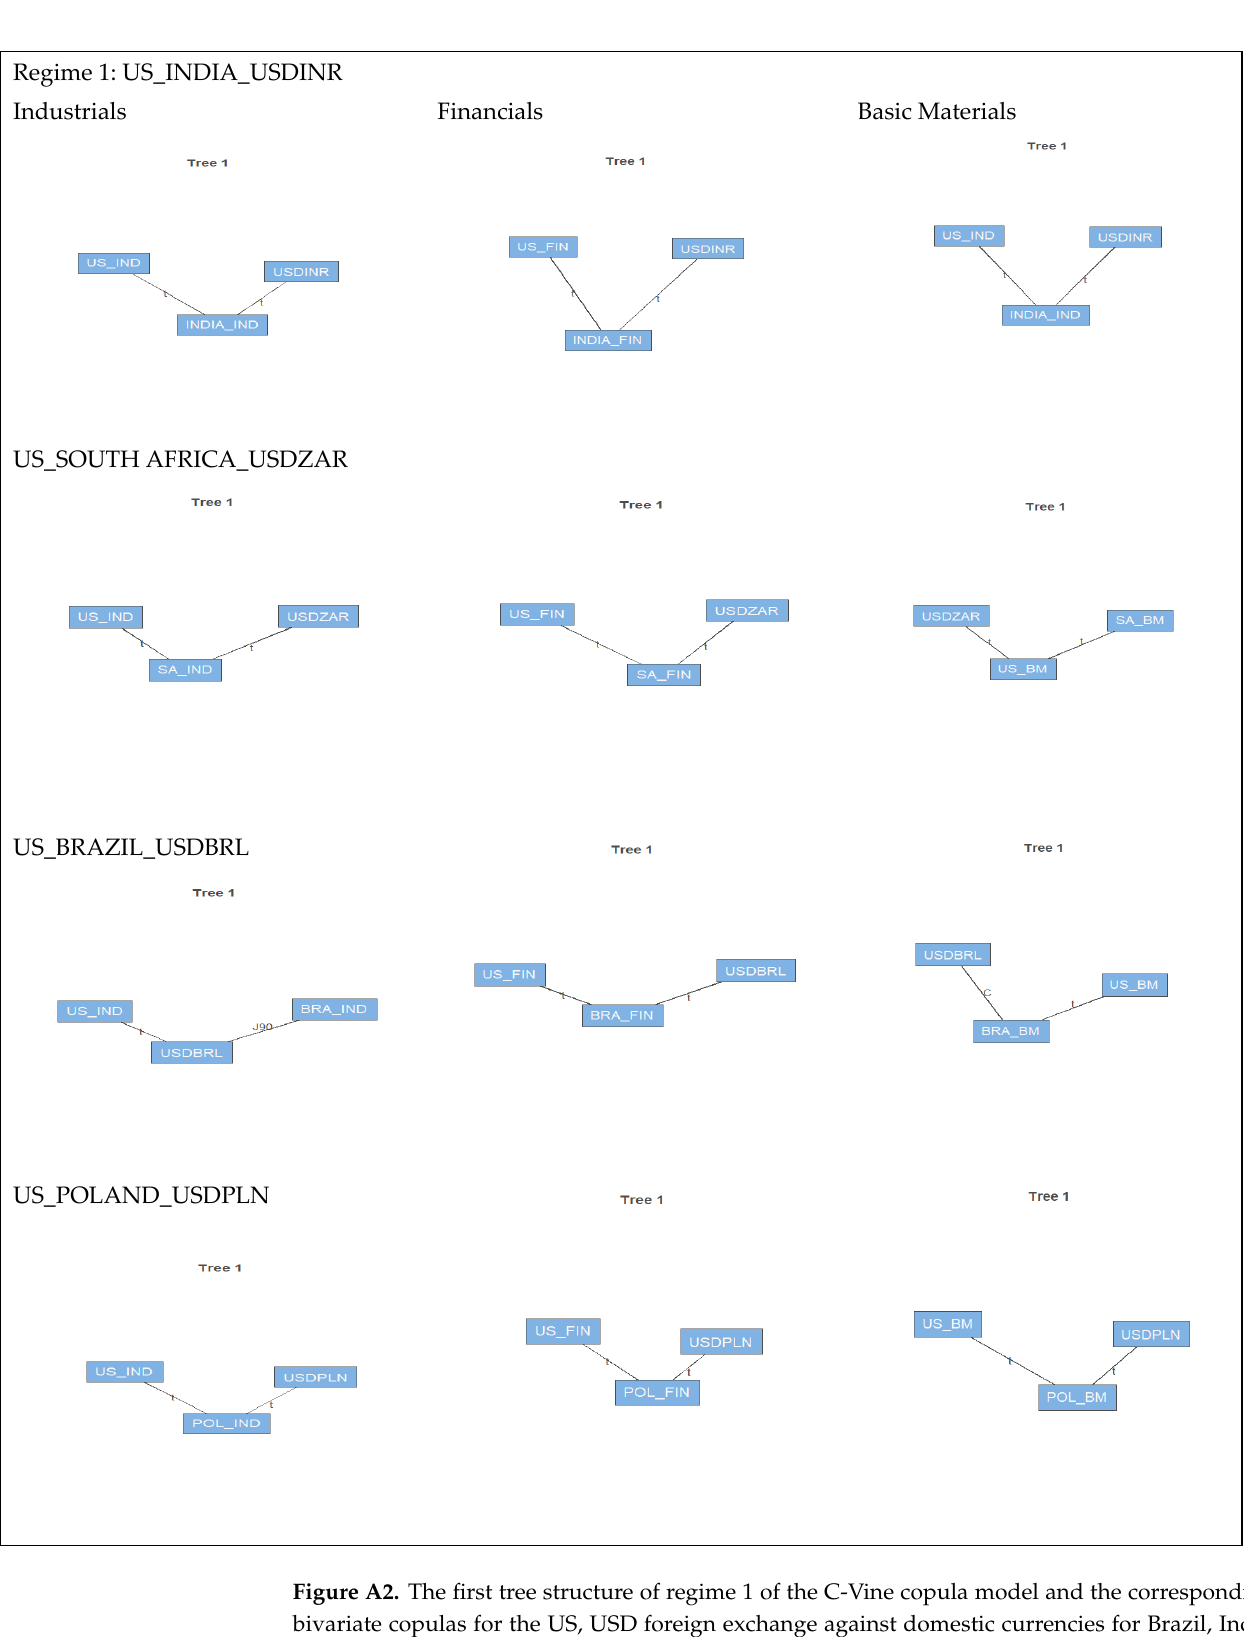
Figure A2. The first tree structure of regime 1 of the C-Vine copula model and the corresponding bivariate copulas for the US, USD foreign exchange against domestic currencies for Brazil, India, Poland and South Africa, and their sectorial equity markets.